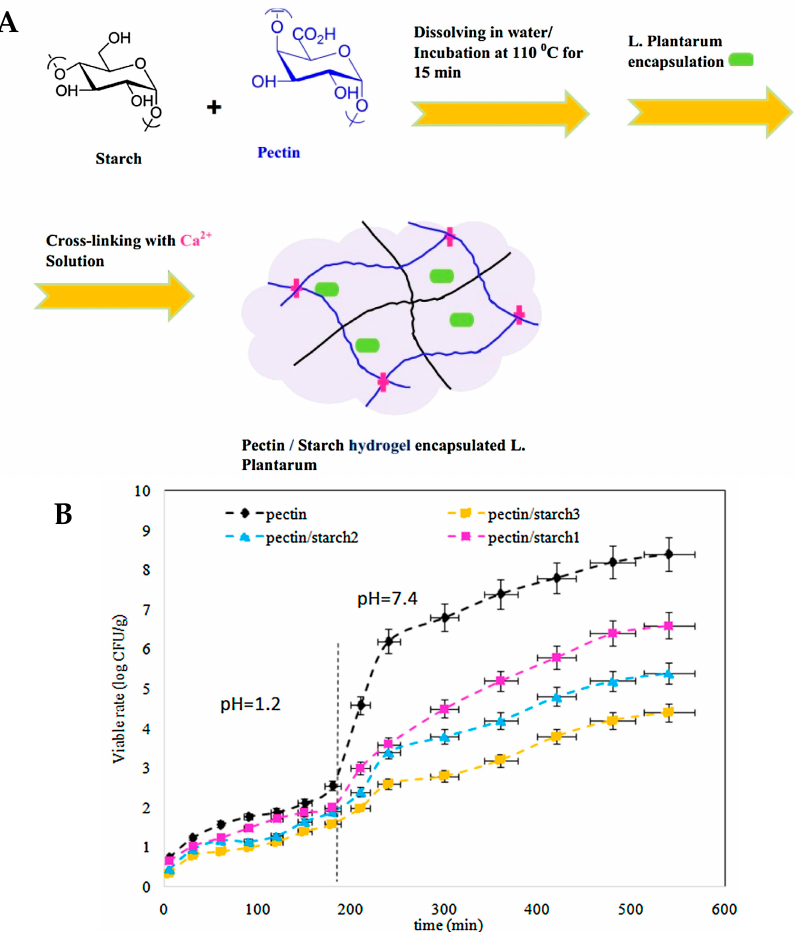
Figure 12. ( A ) Schematic illustration of the preparation of pectin/starch hydrogels encapsulated Lactobacillus plantarum ( L. plantarum ) cells. ( B ) Release profile of encapsulated cells in buffered solution with pH 1.2 and pH 7.4; Values shown are means ± standard deviations ( n = 3). (Reprinted with permission from reference [57]. Copyright 2017 Elsevier).